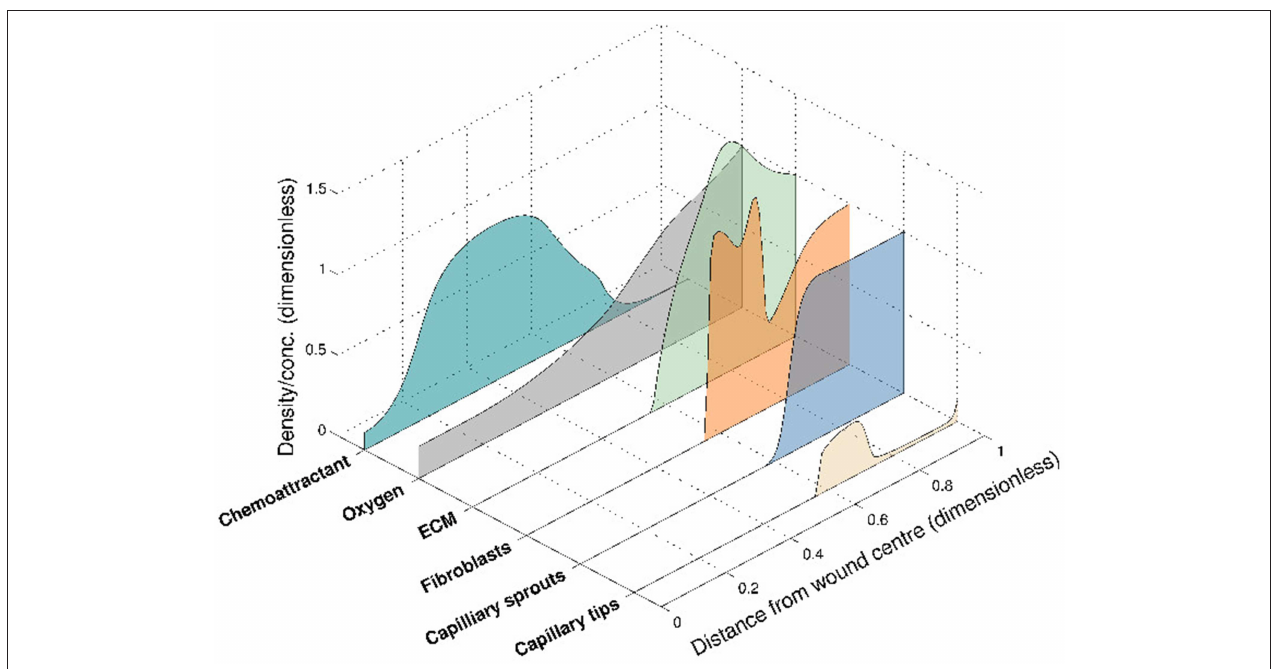
FIGURE 3 | Numerical simulation of the 6-species Pettet et al. model, showing the spatial distribution of the species within the wound at a certain time for a given set of parameter values. The wound healing unit moves through the wound space, from wound edge to wound center.